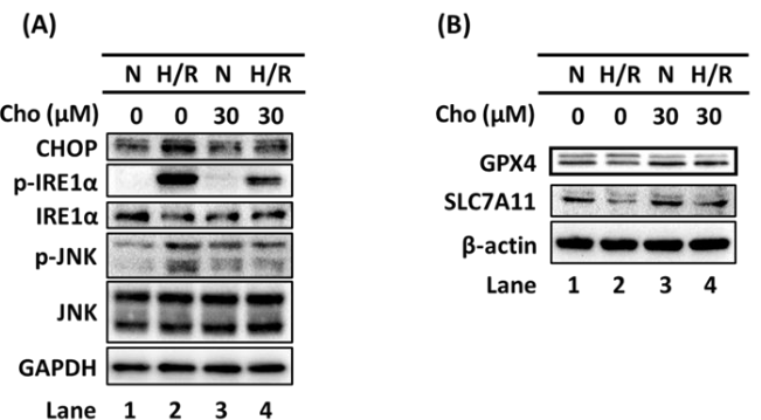
Figure 2. Chrysophanol alleviated H/R-induced ER stress and ferroptosis. ( A ) Changes in the expression of p-IRE1 α . GAPDH was used as an internal control. ( B ) Changes in the expression of GPX4 and SLC7A11. β -actin was used as an internal control. Cho: Chrysophanol. H/R: Hypoxia/reoxigenation. N: Normoxia. n = 3.